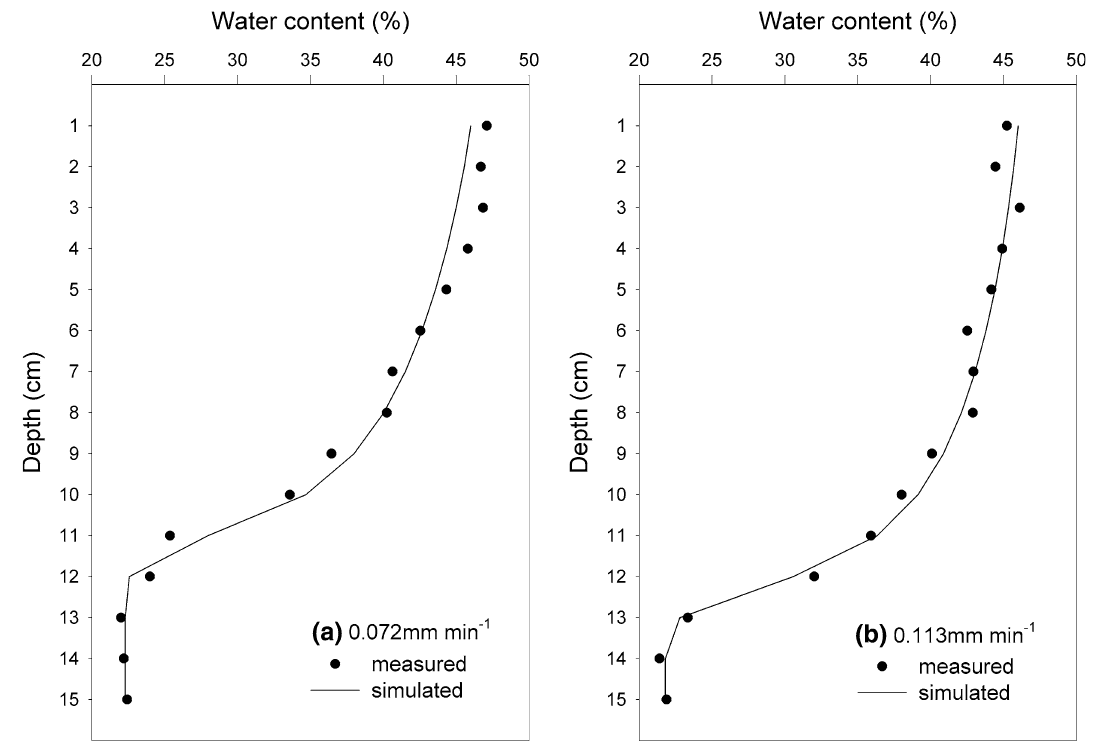
Fig. 4 Comparison of model results with the measured experimental soil moisture content for two artificial rainfall experiments with stems and leaves removed